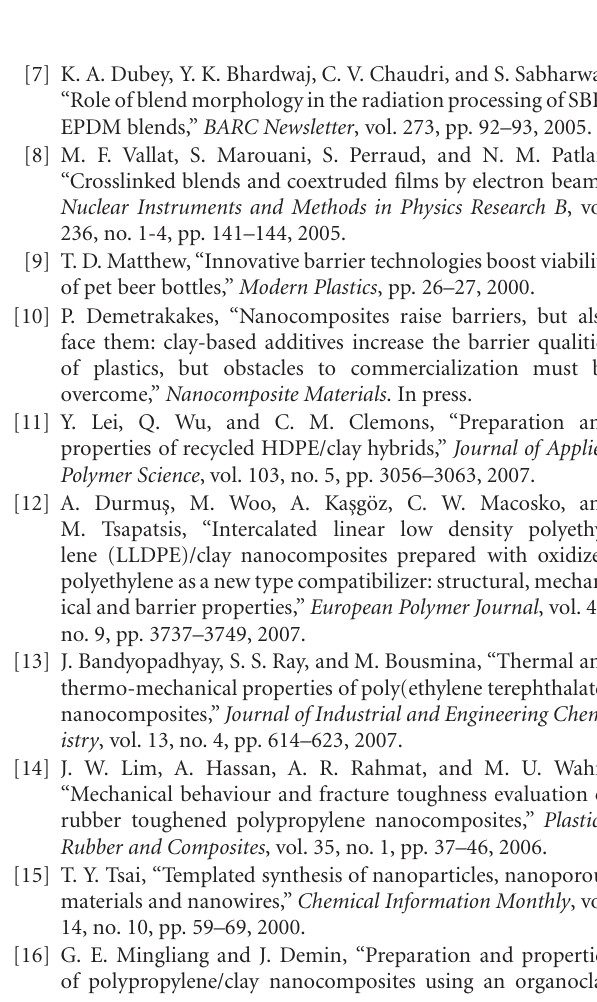
Figure 7: Oxygen transmission rate (O 2 TR) of unfilled composites and nanocomposites for control and EB-irradiated